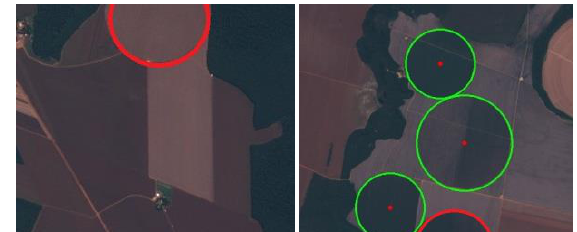
Figure 10. Missed detections of PVANET-Hough (red ones)